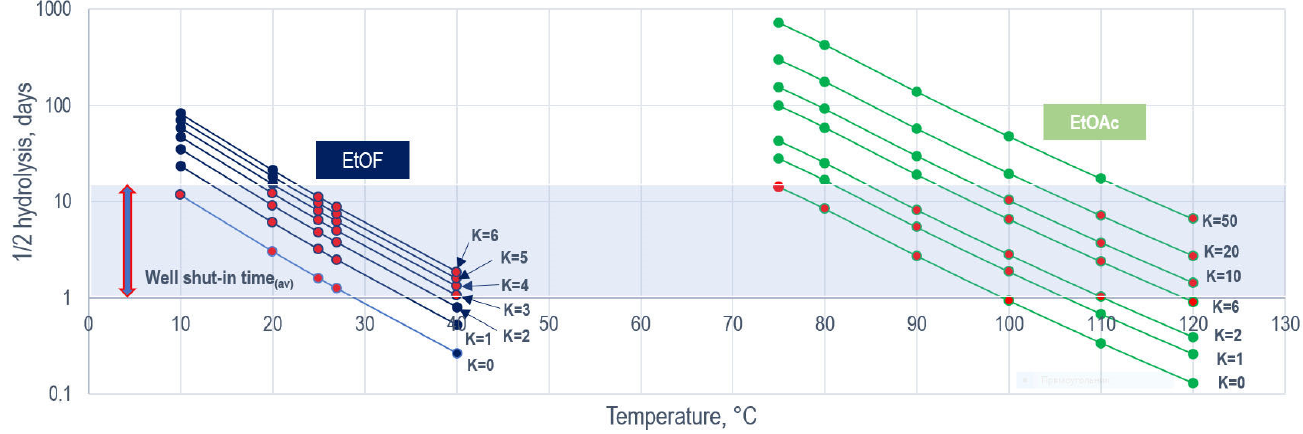
Figure 3. One-half hydrolysis (neutral) of ethyl formate and ethyl acetate in the temperature range at various K -value and S or = 0.5 (log scale).